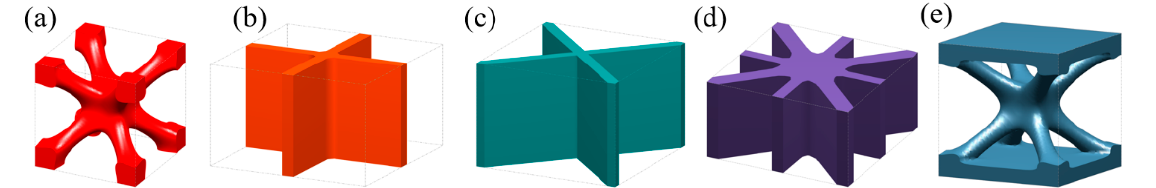
Figure 2. Unit cells constructed by LSF. ( a ) Triply periodic minimal surface (I-WP). ( b ) Cross-shaped stiffening rib unit cell. ( c ) X-shaped stiffening rib unit cell. ( d ) Hybrid stiffening rib unit cell. ( e ) Lattice sandwich structure unit cell.